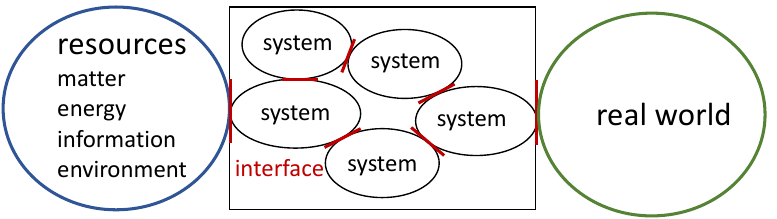
Figure 1. Input/output system with interfacing connects resources to the real world.